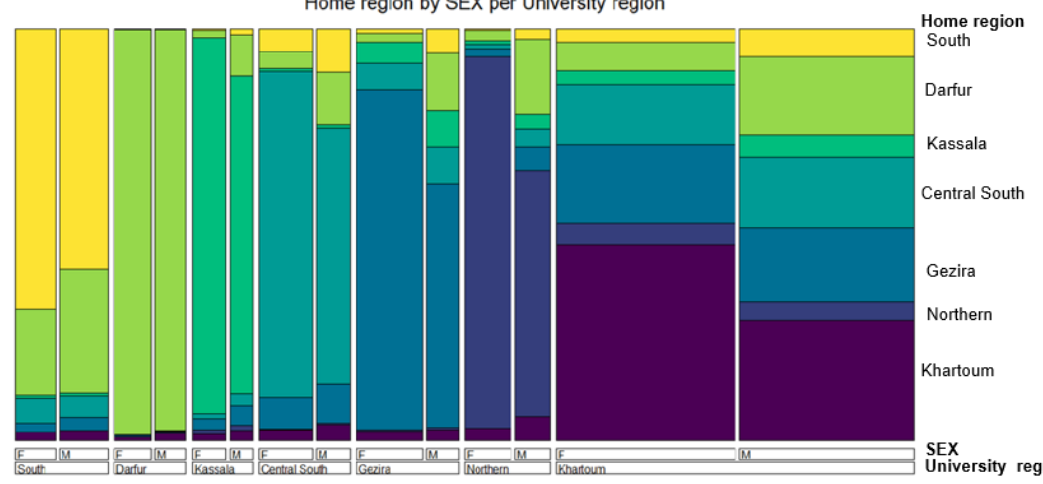
Figure 19. Double-decker plot showing the regional diversity of universities in different regions for 2016–2017 incoming male and female bachelor’s